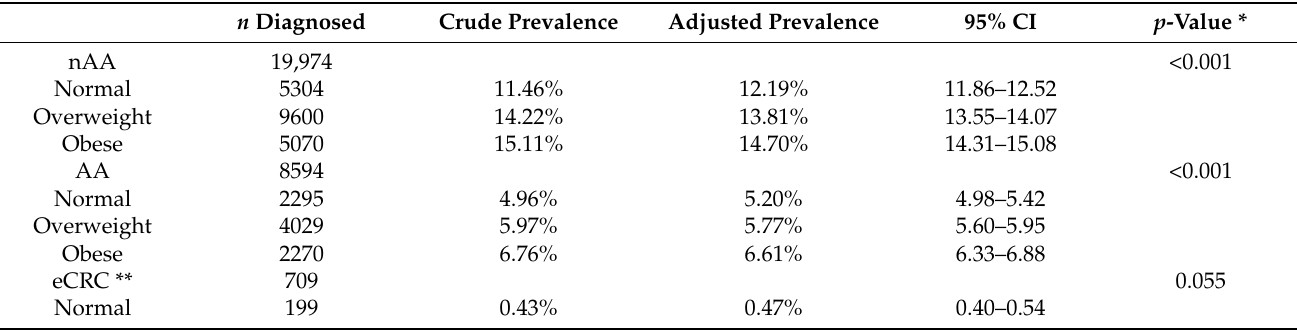
Table 2. Crude and adjusted prevalence of colorectal